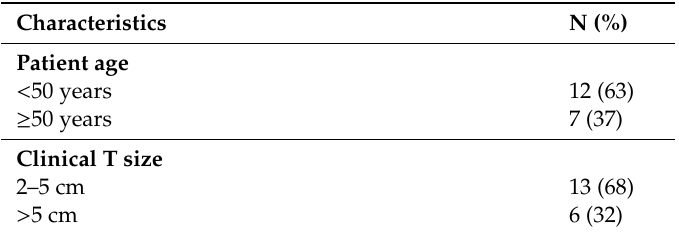
Table 1. Patient, primary tumor, and treatment